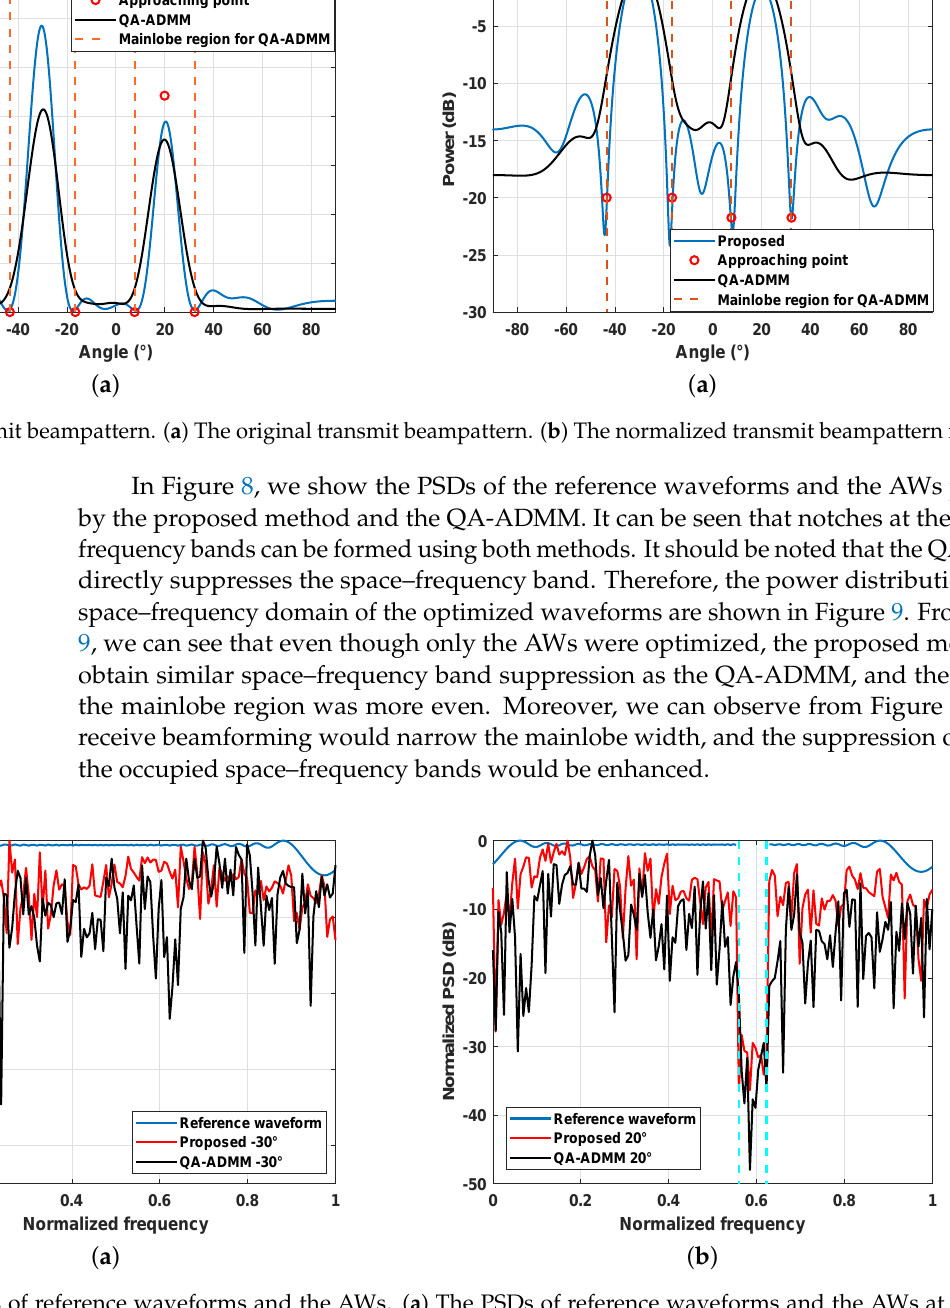
Figure 8. The PSDs of reference waveforms and the AWs. ( a ) The PSDs of reference waveforms and the AWs at − 30 ◦ . ( b ) The PSDs of reference waveforms and the AWs at 20 ◦